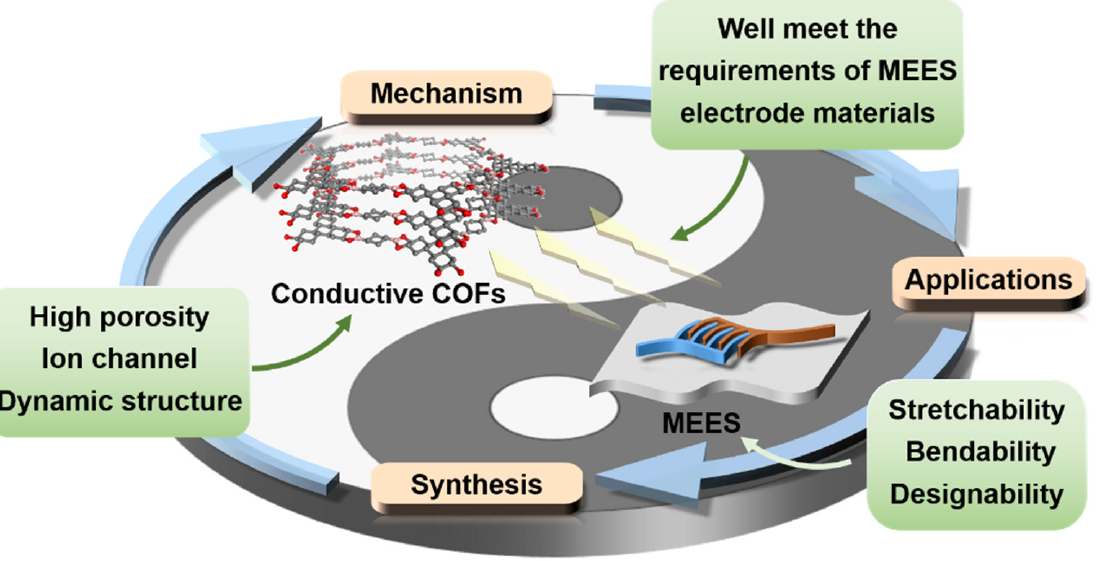
Figure 1. Illustration of the customization of electrode materials for MEES devices via various strat- egies.